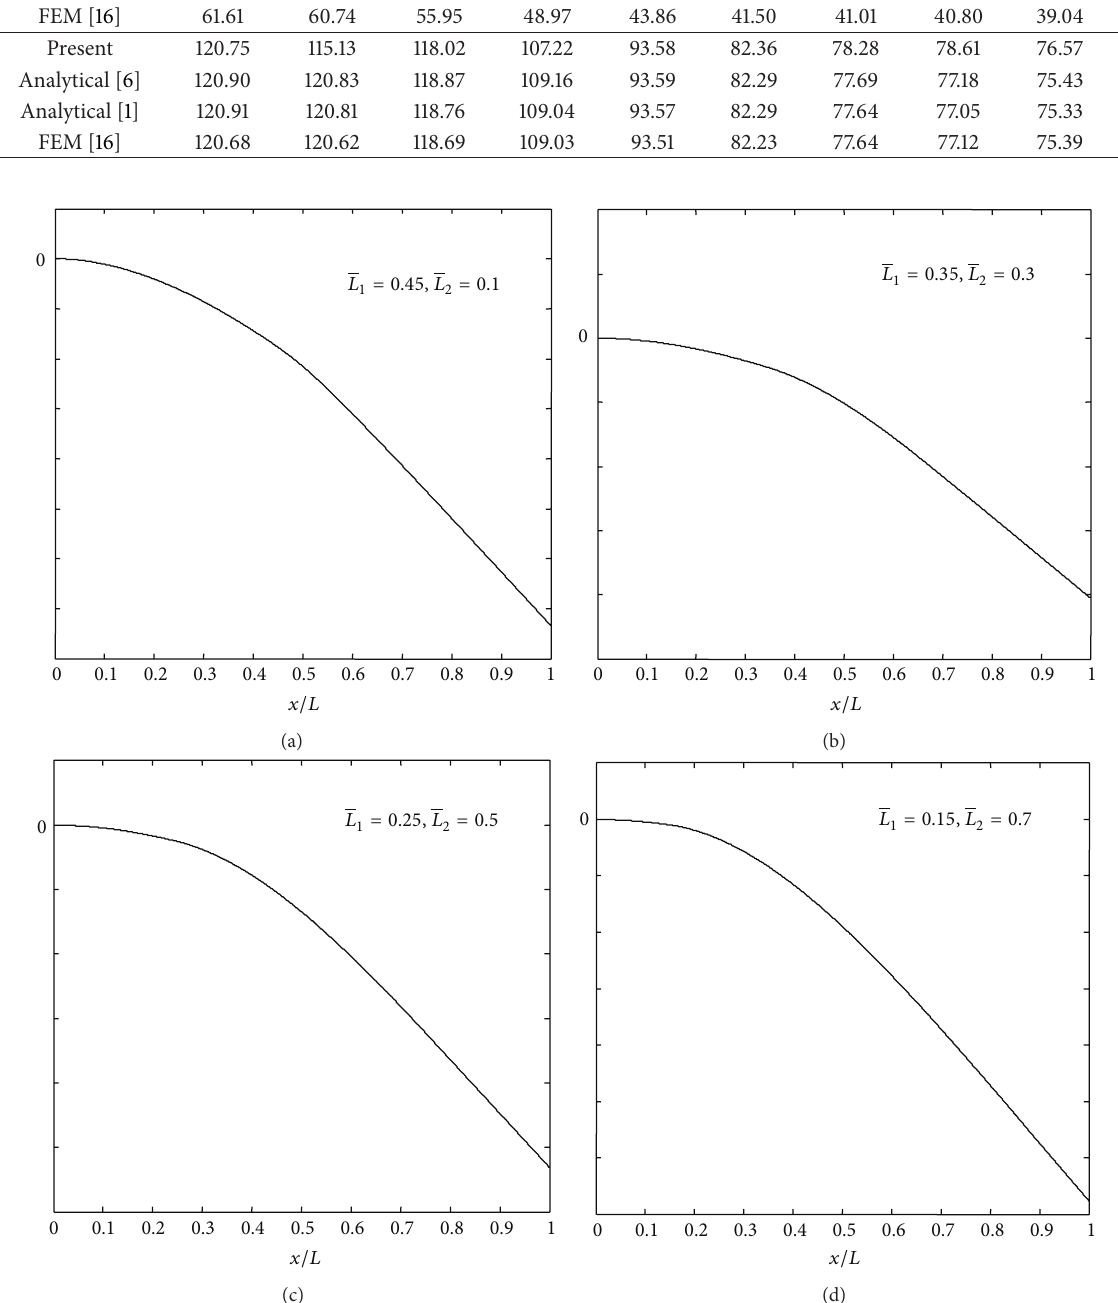
Figure 4: Mode shapes of the delaminated beam with ( 𝐻 2 = 0.5